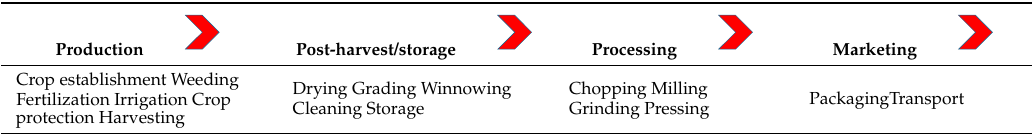
Table 3. The potential for mechanization along the agricultural production value chain.